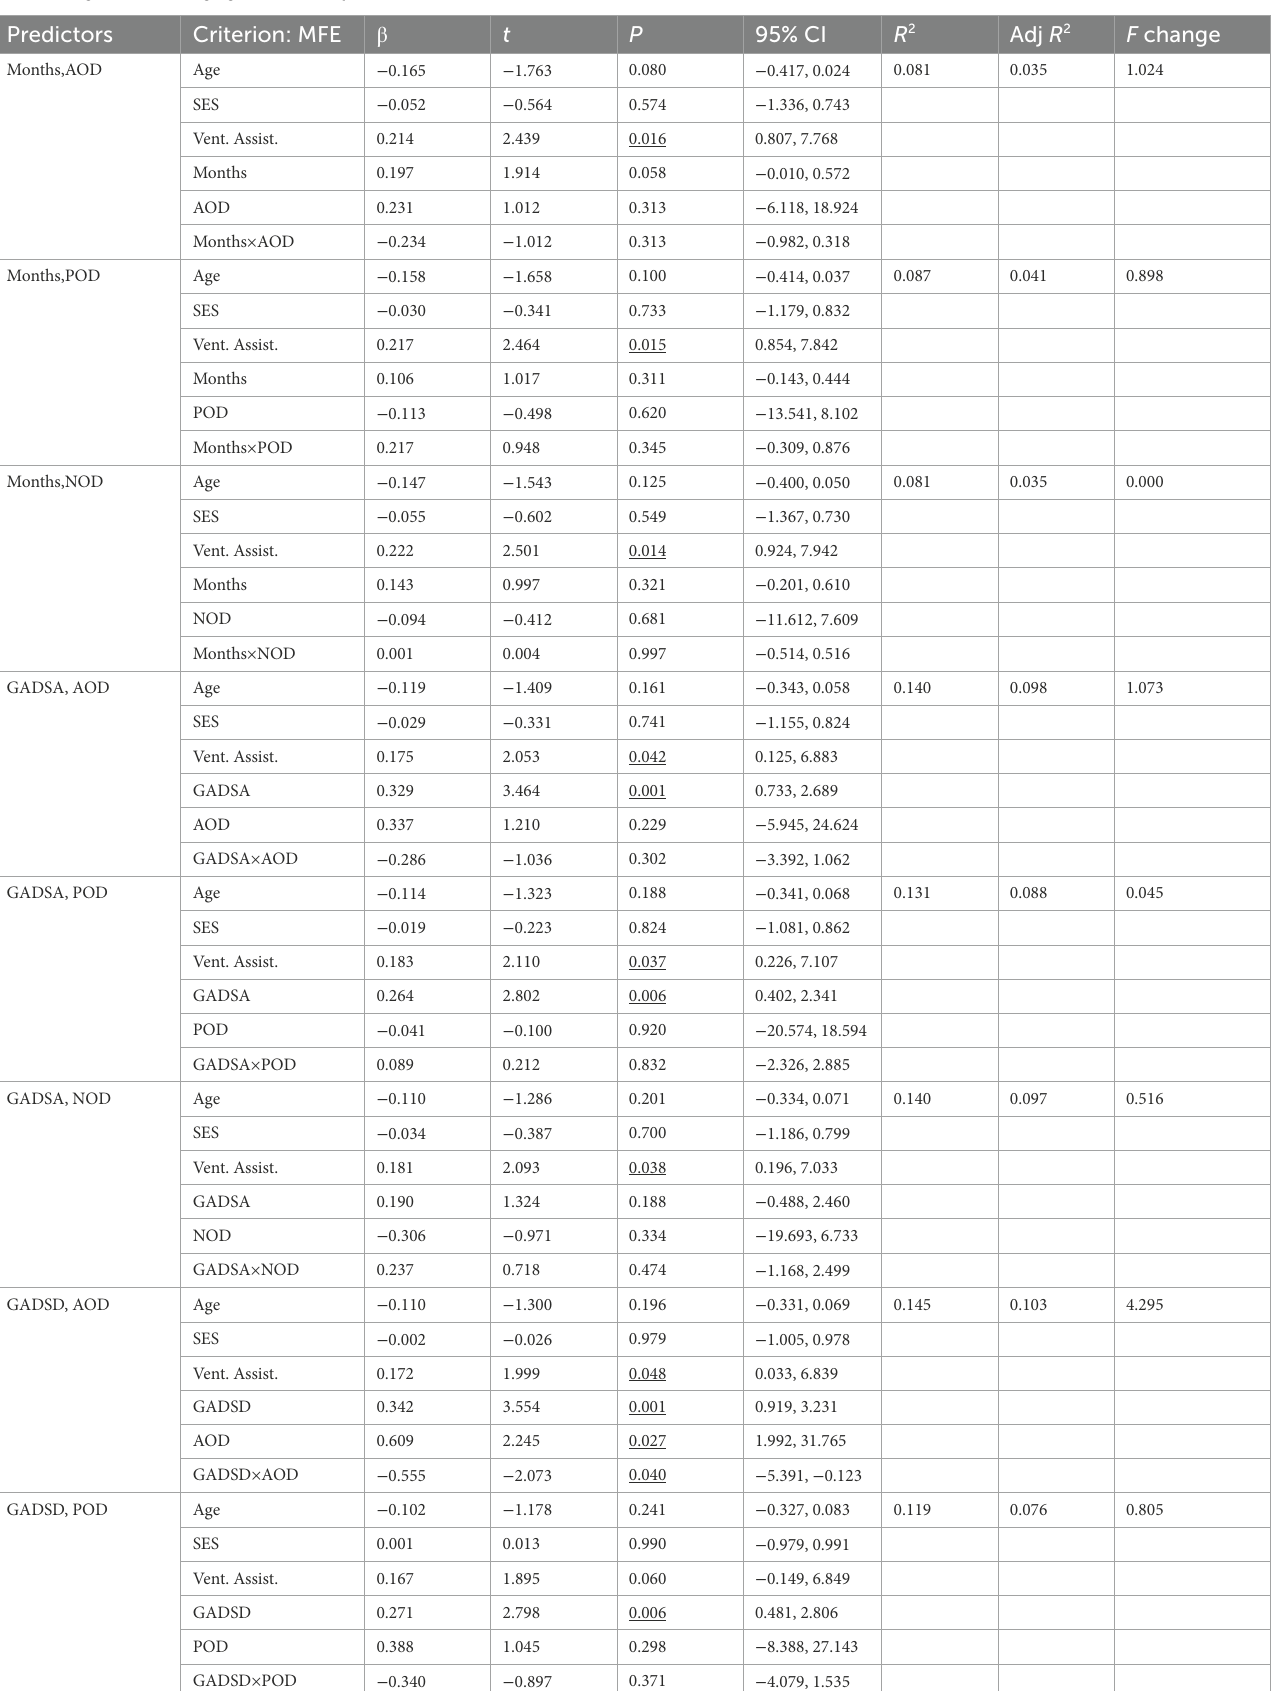
TABLE 5 Multiple regressions predicting self-rated memory failures (MFE score), with months since COVID-19 onset, symptoms of anxiety and depression, trait-anxiety, and olfactory dysfunction as predictors.